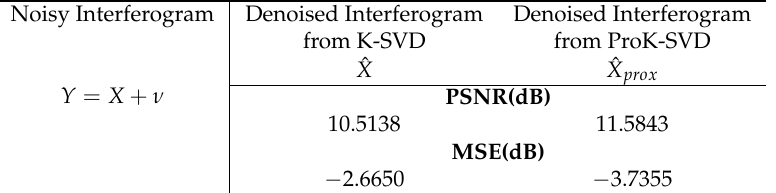
Table 1. Peak Signal-to-Noise Ratio (PSNR) and Mean Standard Error (MSE) metrics for noisy simulated